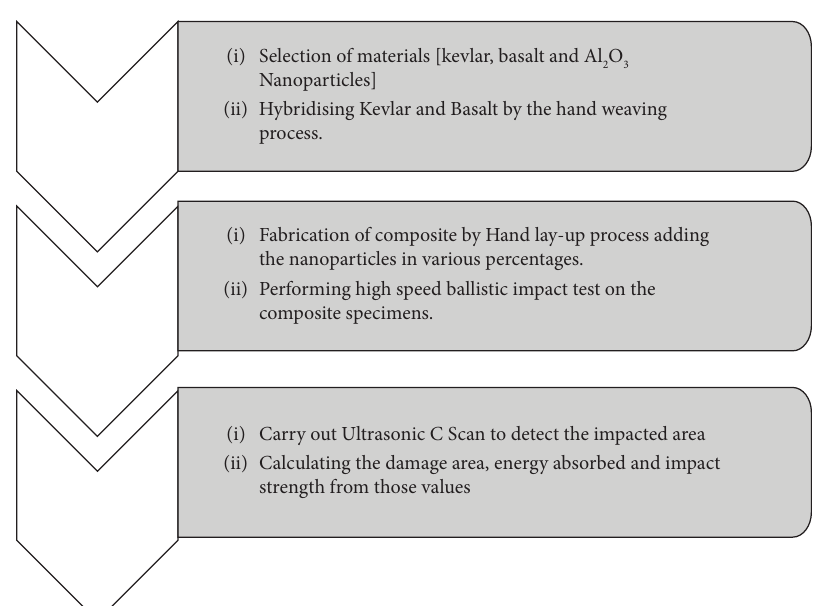
Figure 3: Flow chart for fabrication process and testing of Kevlar/basalt-epoxy interwoven composite.